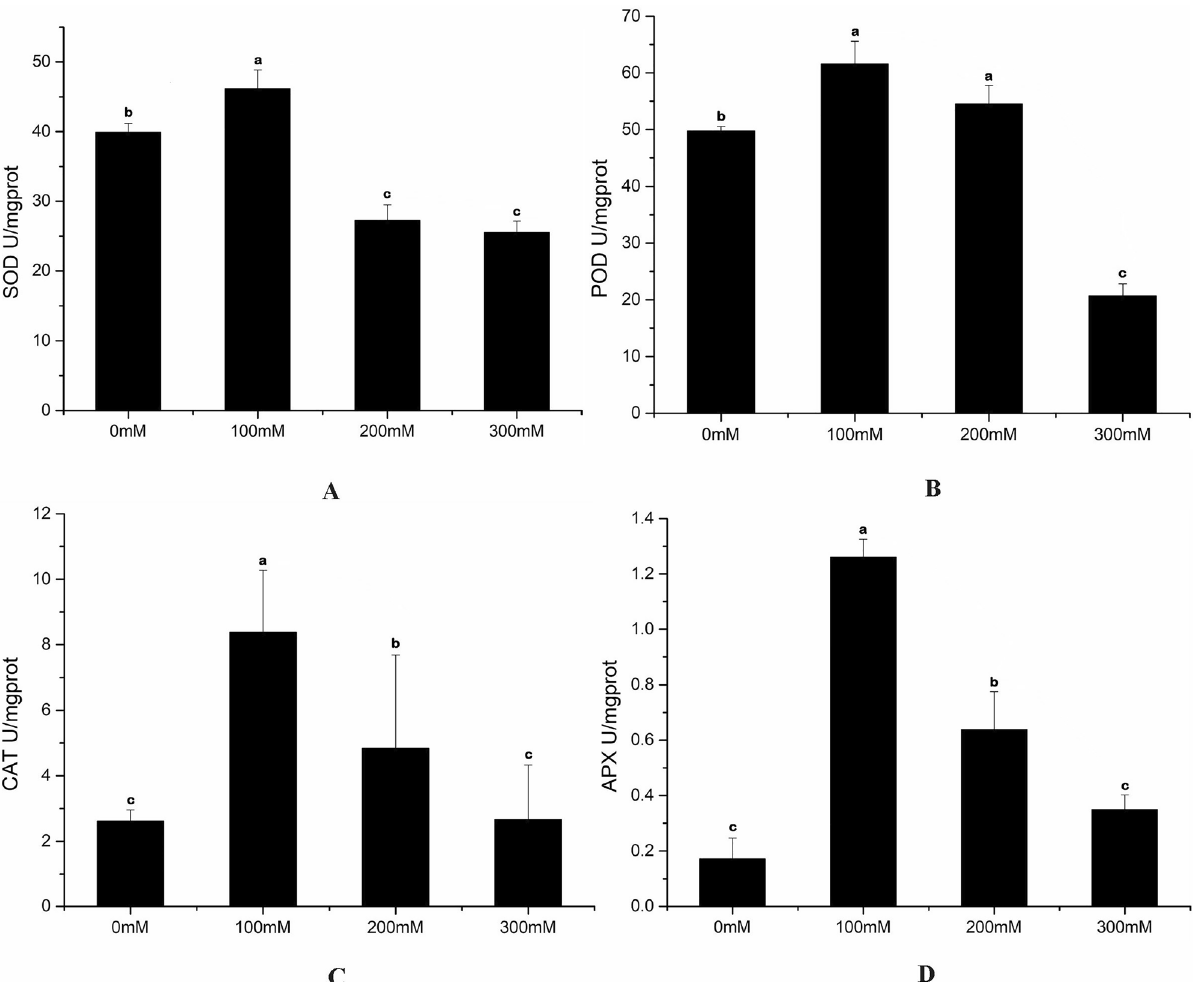
Figure 3. Changes in superoxide dismutase (SOD, A ), peroxidase (POD, B ), catalase (CAT, C ), ascorbate peroxidase (APX, D ) activity under different concentrations of NaCl (The bars were standard deviation (SD) in